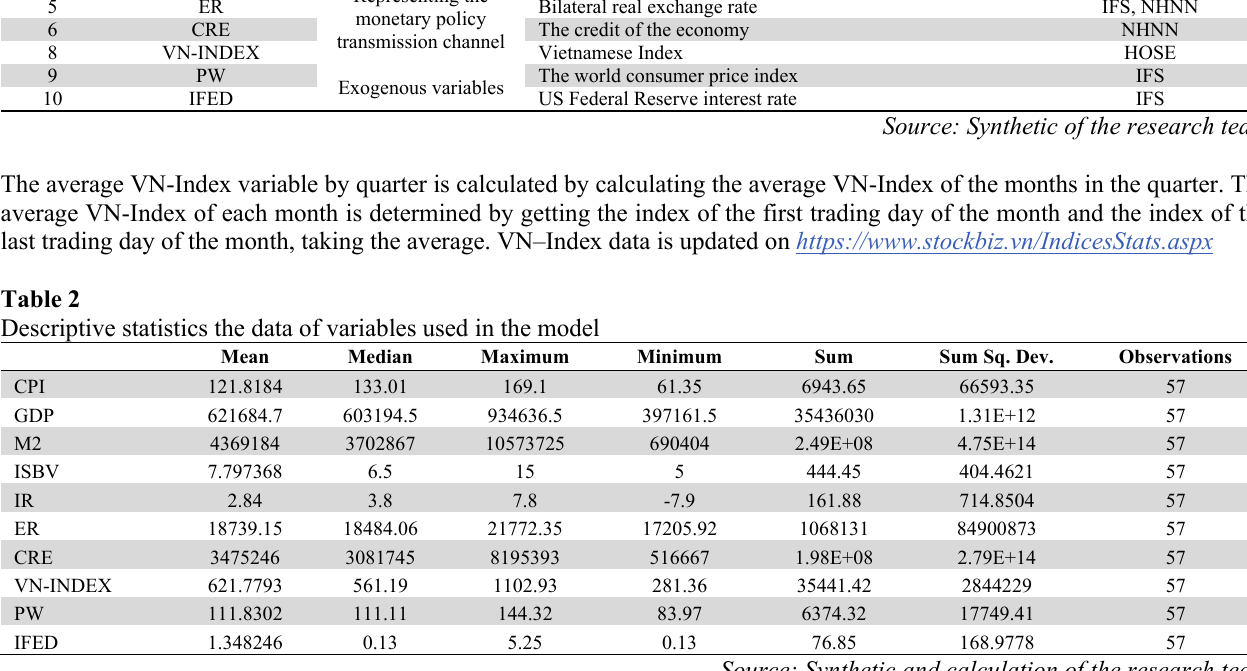
Source: Synthetic and calculation of the research